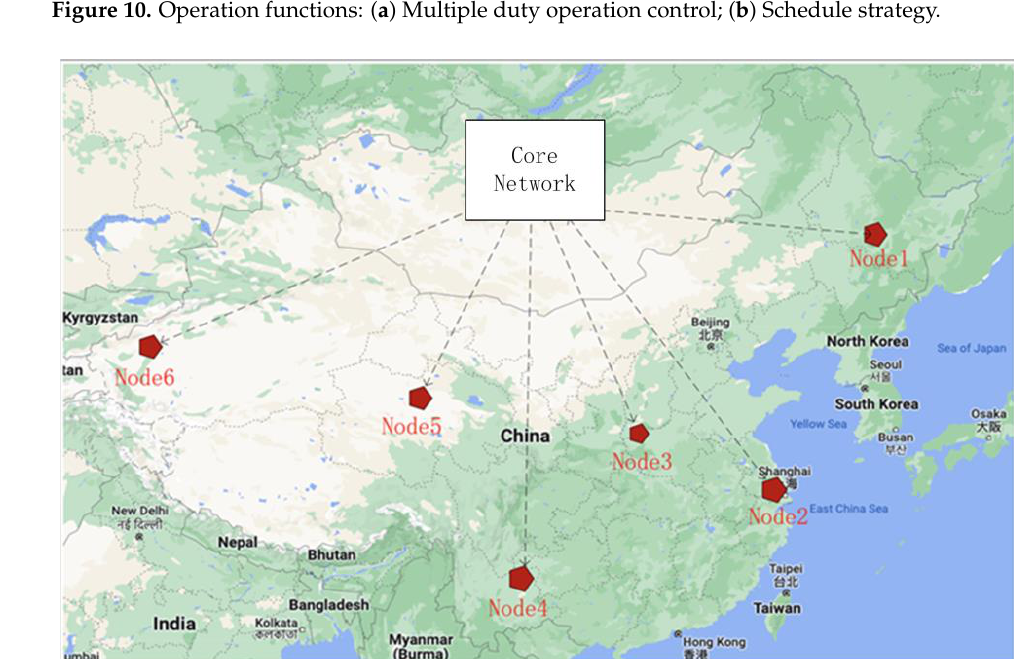
Figure 11. Ground gateway distribution.